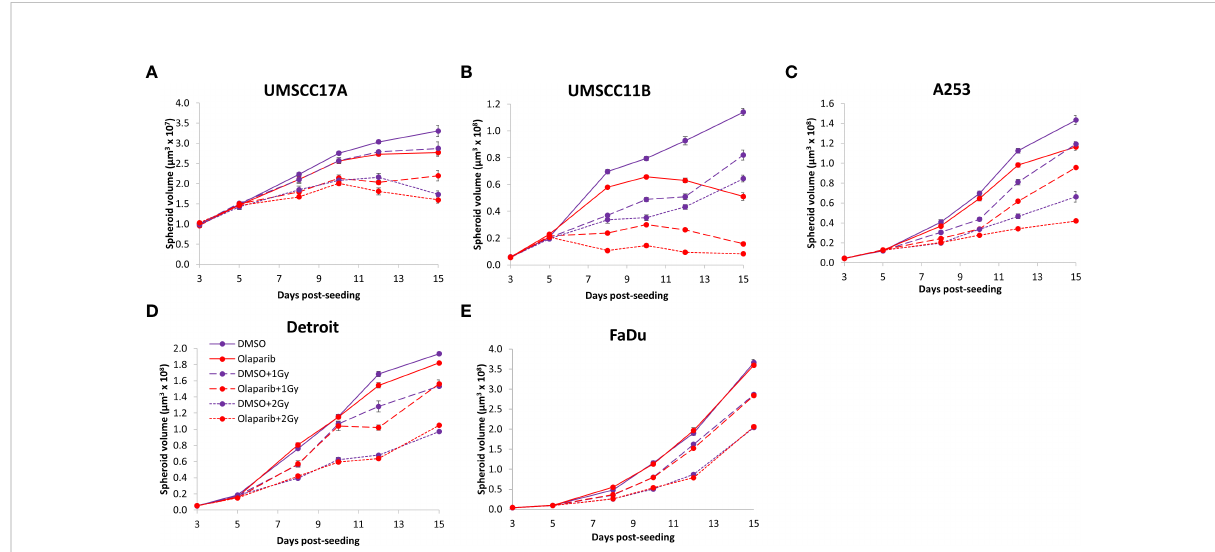
FIGURE 4 Impact of olaparib on the radiosensitivity and growth of HPV-negative HNSCC spheroids. Spheroids were allowed to develop for 24 h in ultra- low attachment plates, treated with DMSO or olaparib (0.1 µM) for a further 24 h, and then unirradiated or irradiated (1 or 2 Gy) on day 3 with a single dose of x-rays. Growth of spheroids derived from cells from (A, B) the larynx (UMSCC17A and UMSCC11B), (C) the salivary gland (A253), and (D, E) the hypopharynx (Detroit 562 and FaDu) were measured by microscopy up to 15 days post-seeding and analysed from three biologically independent